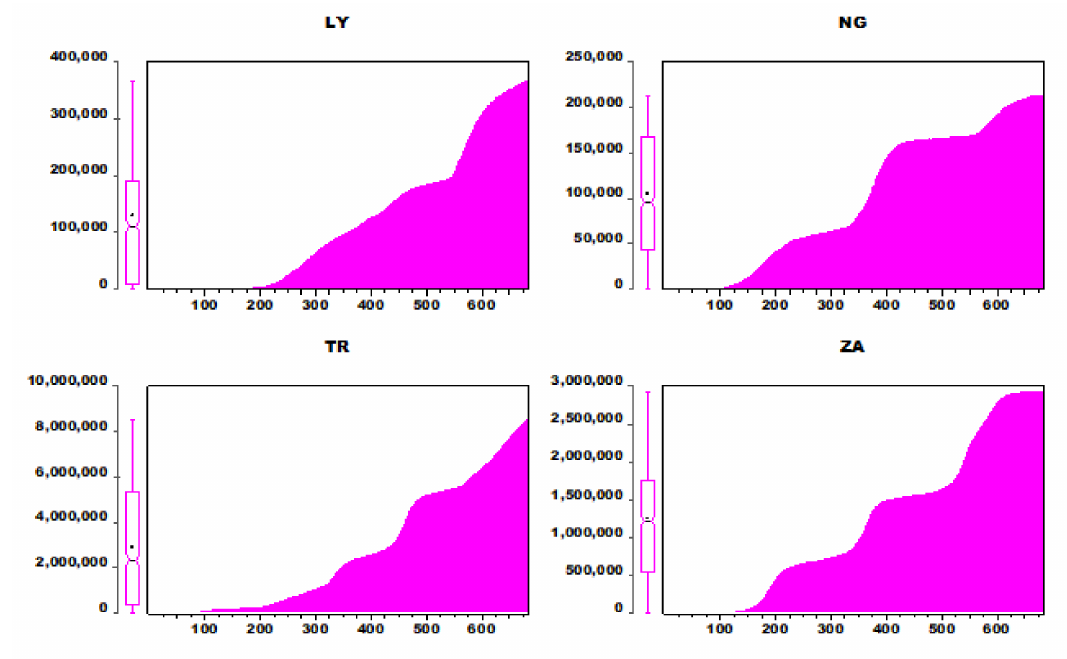
Figure 6. Bar plot of CCC for the four regions.